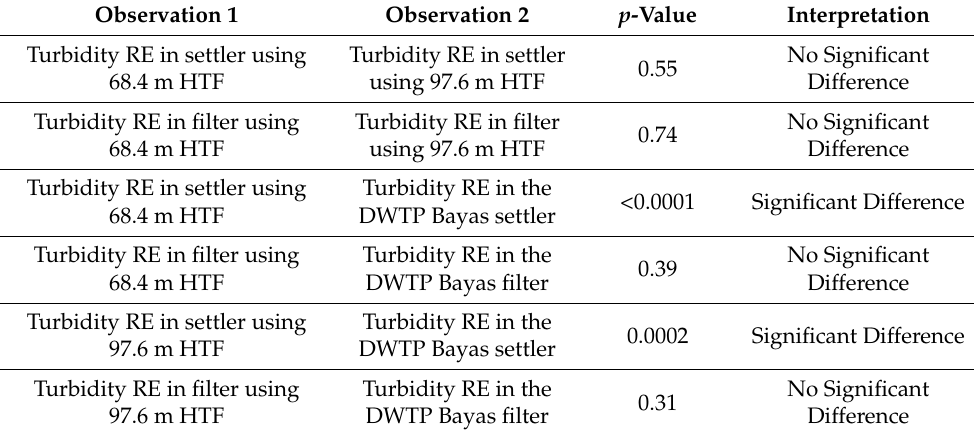
Table 8. p -value of Turbidity Removal Efficiency with HTF of 68.4 and 97.6 m.